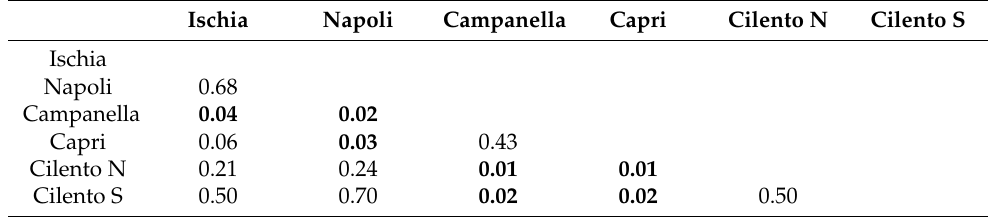
Table 2. Pairwise tests among investigated areas for CSS densities. The significant p -values are shown in